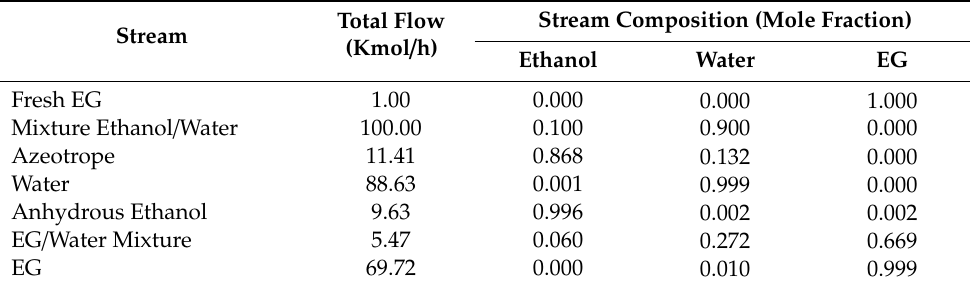
Table 5. Stream composition.